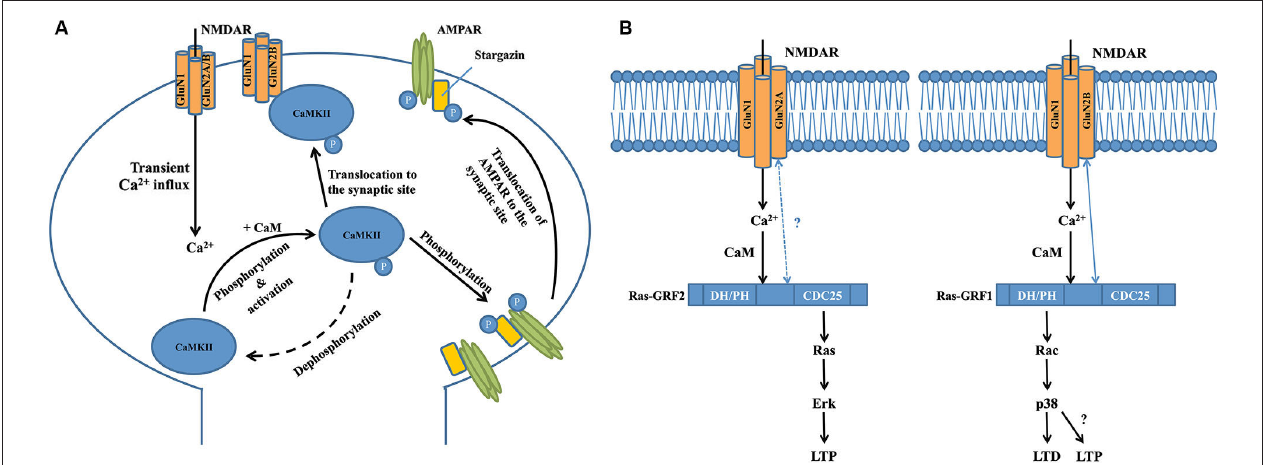
trafficking of AMPAR from the extrasynaptic space to the synaptic region so as to enhance synaptic transmission. (B) Transient calcium influx through GluN2B-containing NMDAR selectively activates Ras-GRF1 that contributes to LTD by activating the downstream Rac/p38 pathway, while calcium influx through GluN2A-containing NMDAR selectively activates Ras-GRF2 that contributes to LTP by activating the downstream Ras/ERK pathway. There is a selective physical interaction between Ras-GRF1 and the GluN2B subunit of NMDAR, but there is no evidence supporting the interaction between Ras-GRF2 and GluN2A subunit of NMDAR. Interestingly, a recent study showed that starting at 2 months of age in mice, Ras-GRF1 starts to contribute to the induction of LTP in the CA1 of hippocampus via the Rac/p38 pathway, however the exact mechanism is still